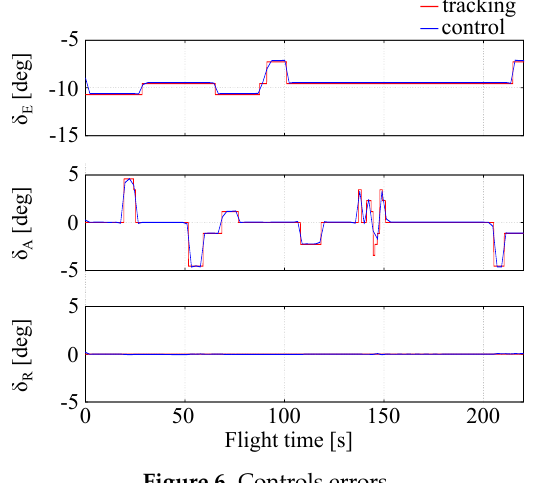
Figure 6. Controls